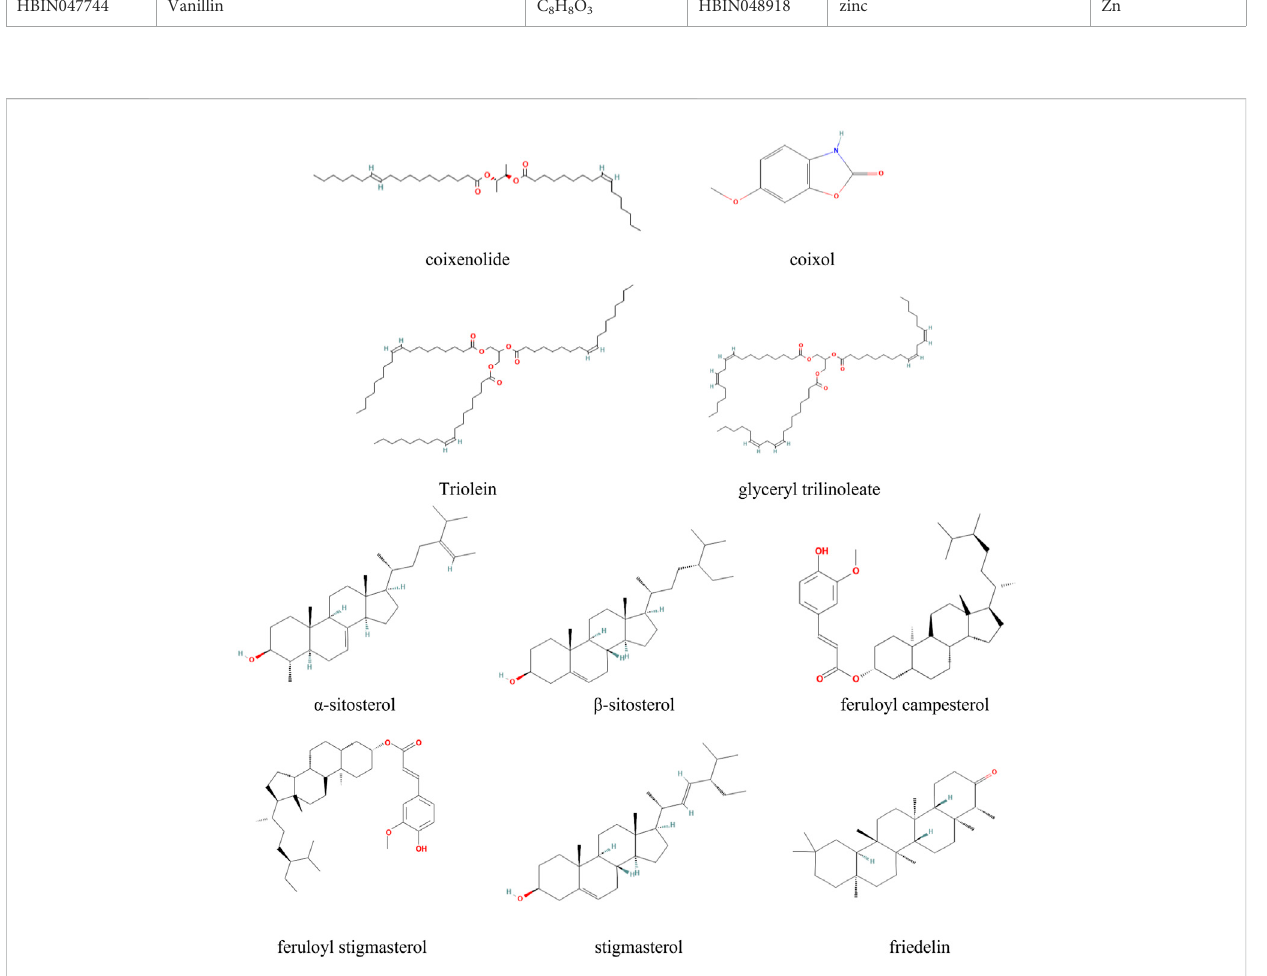
FIGURE 2 Structures of the major active compounds present in Coicis